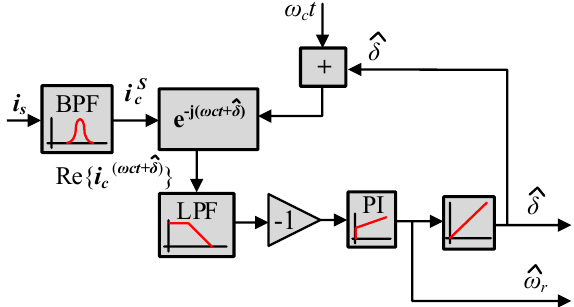
Figure 2. Demodulation scheme for the traditional